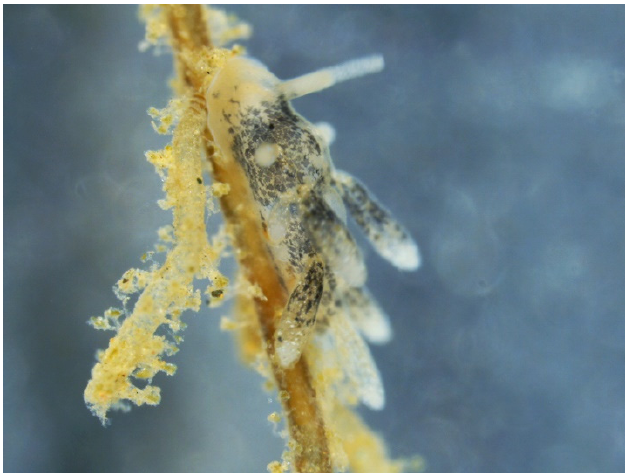
Figure 2. One of the adults of Tenellia adspersa collected in the Guadiana estuary on 26 July 2016. Table 1. Salinity and temperature measurements along the seven sampling stations in the Guadiana estuary on 26 July 2016.